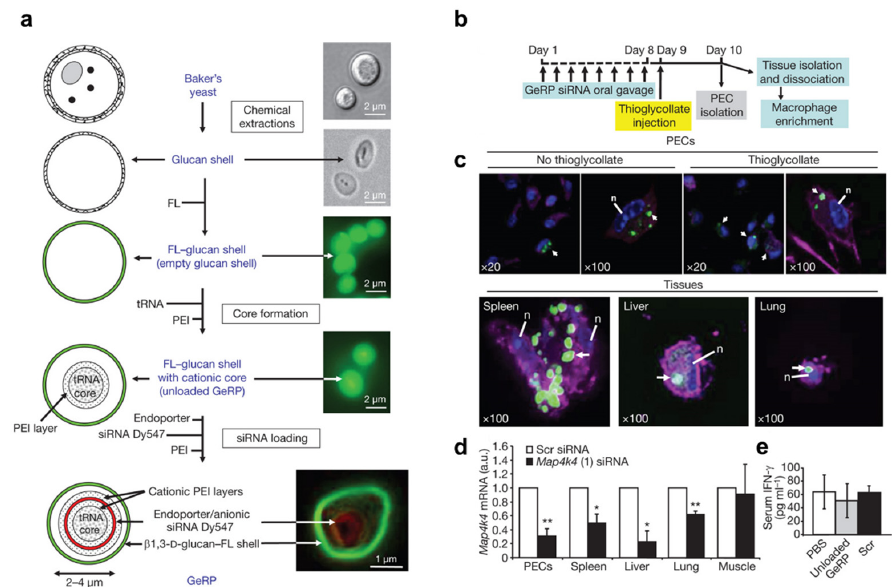
Figure 5. Polyplex embedded in polymeric materials. ( a ): Production of fluorescent GeRPs. ( b ): Timeline of GeRP (scrambled (Scr) or Map4k4, oligo (1)) administration and PEC/tissue isolation. ( c ): Confocal microscopy of PECs and tissue macrophages containing GeRPs (green). ( d ): Map4k4 mRNA expression in polyelectrolyte complexes (PECs) and adherent cells from tissues. Statistical p -values: * p < 0.05, ** p < 0.01. ( e ): Serum INF- γ levels from mice gavaged with PBS, unloaded GeRPs, or GeRPs Nature. containing 20 µ g · kg − 1 of Scr siRNA. Reproduced with permission [103]. 2009, Springer Table 2. Oral siRNA nano-delivery systems for IBD treatment.